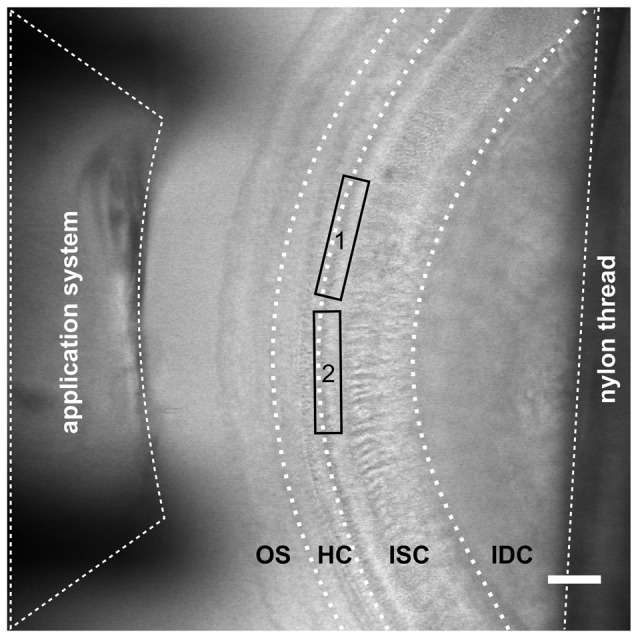
Configuration for imaging inner supporting cell (ISC) Ca2+ waves and inner hair cell (IHC) Ca2+ transients in the immature cochlea of the mouse. Transmitted light image of an acutely dissected whole-mount preparation of the apical turn from a P4 control mouse organ of Corti. The focus is set on the hair cell region (HC) with three rows of outer hair cells and one row of IHCs and the great epithelial ridge with the ISCs. Because of the upward slope of the epithelium towards the modiolus the outer sulcus region (OS) and interdental cells (IDCs) are out of focus. The outlet of a gravity-fed application system made from tapered PVC tubing with an inner diameter of 400 μm was placed at the outer sulcus (pillar) side for gentle application of solutions with blockers or agonists. The tissue was held by two soft nylon threads (one is visible as the rightmost black shadow) fixed to a stainless steel ring that fit into a recording chamber. Care was taken that only the outermost edges of the tissue were held down to the glass bottom of the chamber. One to two recordings were made per apical cochlear turn. Recording frames are depicted by the rectangles labeled 1 and 2. The distance from the thread to the recording site was >200 μm. Scale bar, 50 μm.